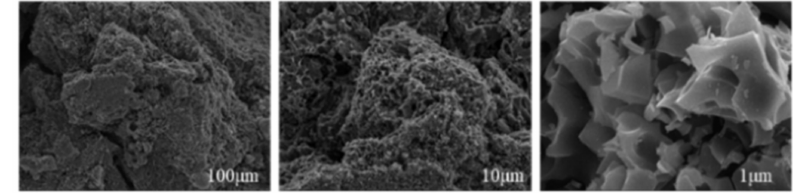
Figure 2. Scanning electron microscope image of CCGS.